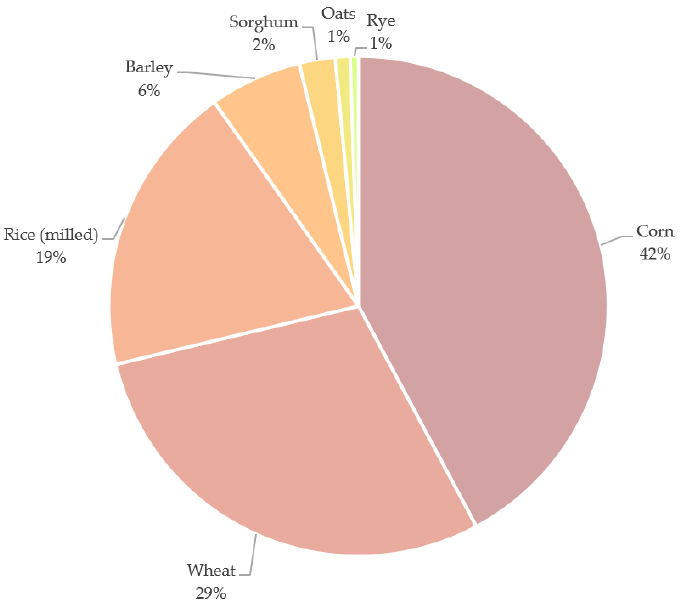
Figure 1. Percentage of worldwide cereals production during 2020/2021. Data source: Statista [8] .